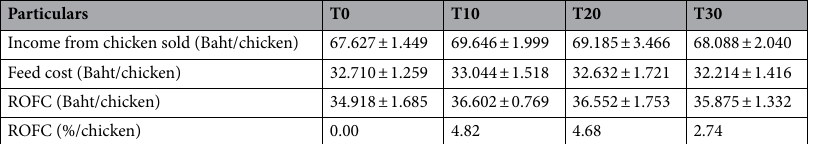
Table 3. The ROFC (Baht/chicken) of female chicken under different treatment groups. ROFC Return over feed cost, means within a row with different superscript differ significantly (p-value < 0.05).